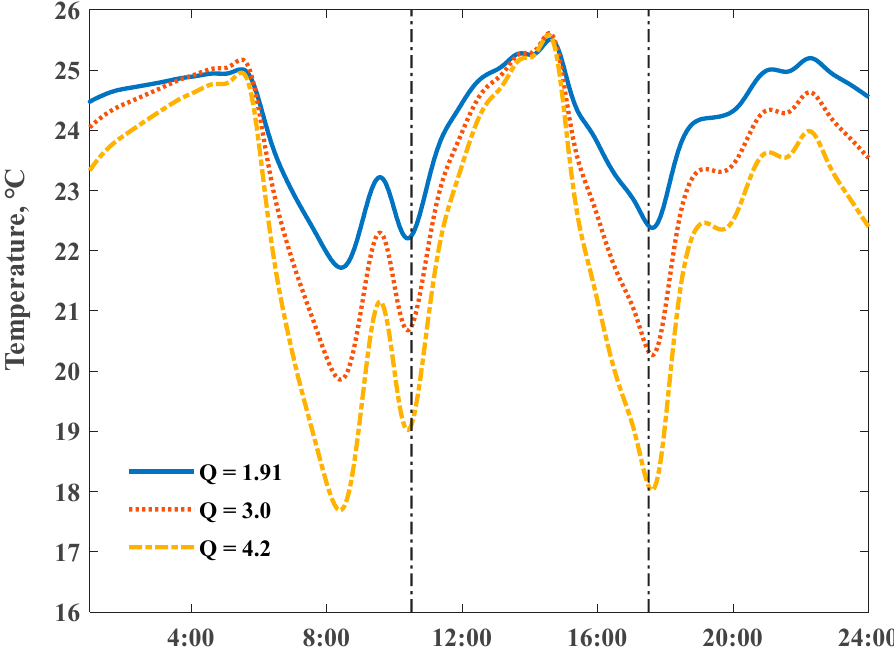
Figure 11. Impact of heat loss coefficient Q values on simulated indoor air temperature profiles, on 18 January 2020.